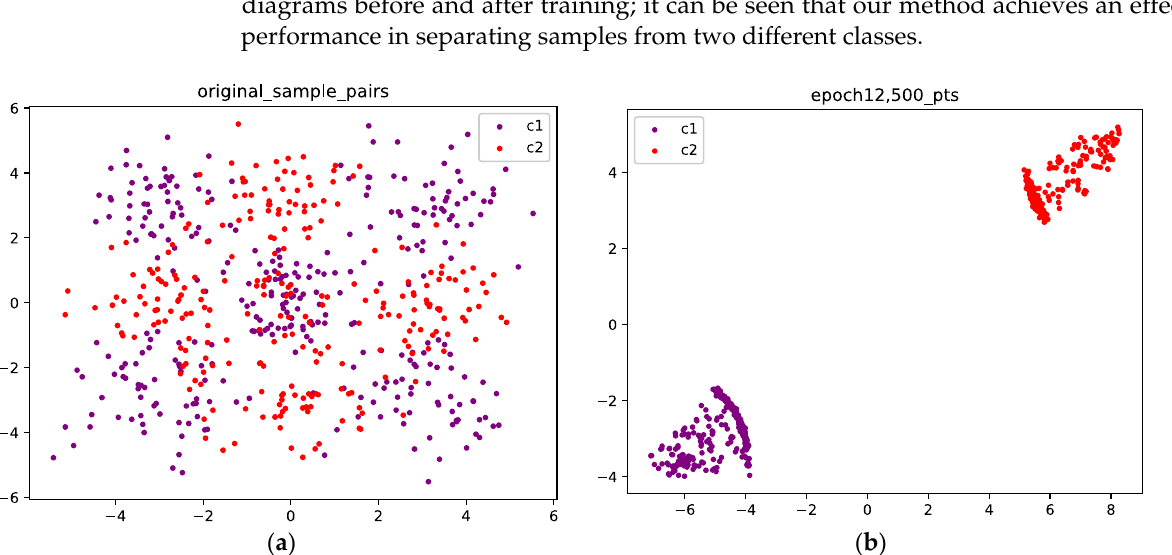
( b ) Figure 12. ( a ) Persistence diagram obtained via persistent homology at epoch 0. ( b ) Persistence dia ‐ gram after 12,500 epochs. Two connected components can be identified; the points with x ≈ 0.5 cor ‐ respond to the first connected component (class 1), and the points with x ≈ 1.0 correspond to the second connected component (class 2). 4.2. Datasets In this part, we use the same models and settings as [22], and we evaluate our method on three vision benchmark datasets: MNIST [26], SVHN [27] and CIFAR10 [28]. For MNIST and SVHN, 250 instances are used for training the model, for CIFAR10, 500 and 1000 instances are used.